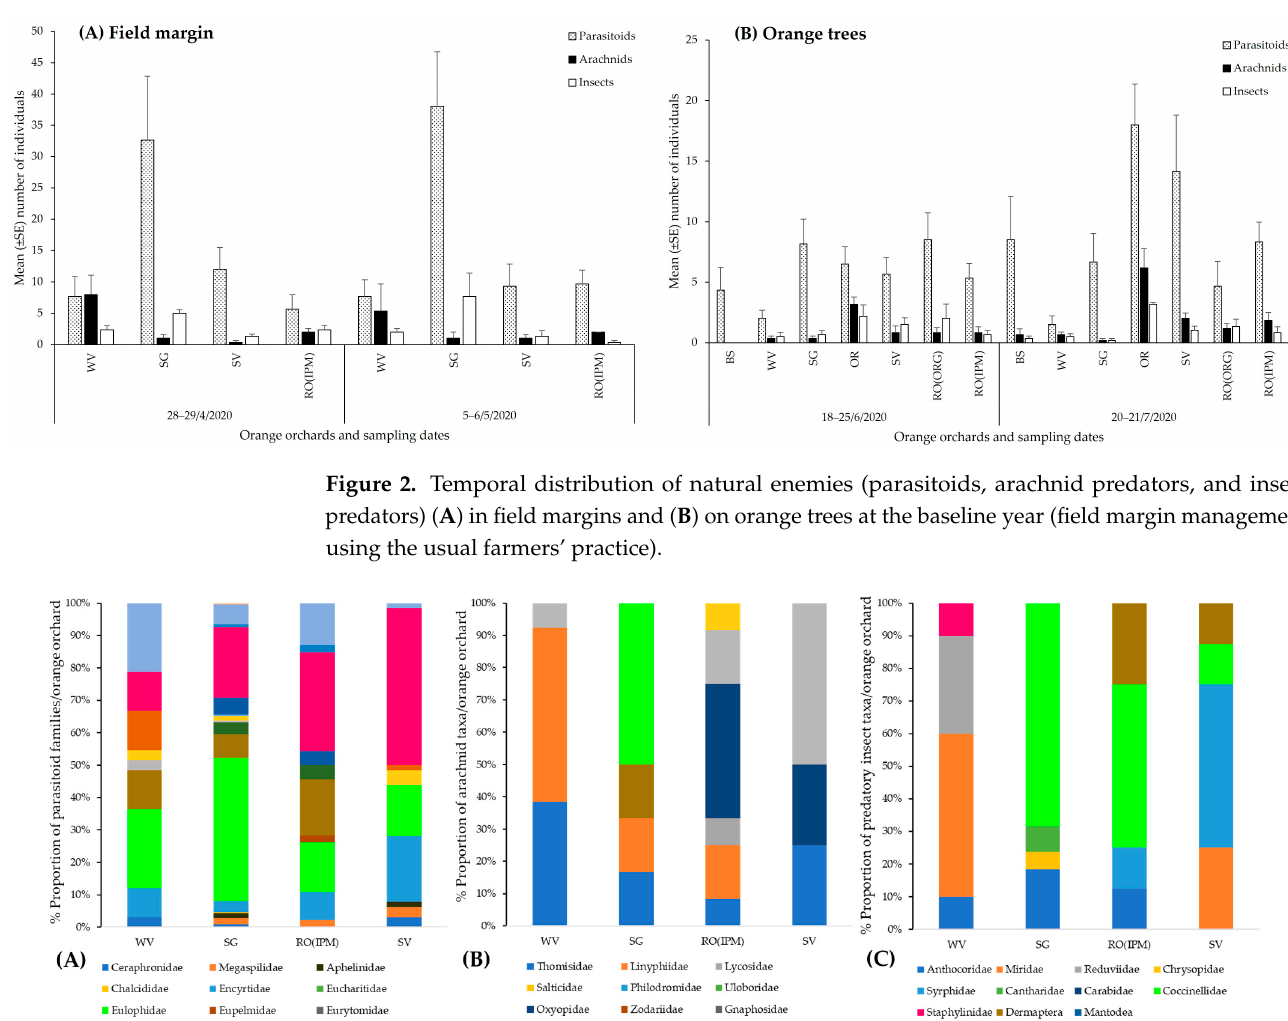
Figure 2. Temporal distribution of natural enemies (parasitoids, arachnid predators, and insect predators) ( A ) in fi eld margins and ( B ) on orange trees at the baseline year ( fi eld margin manage- ment using the usual farmers’ practice).